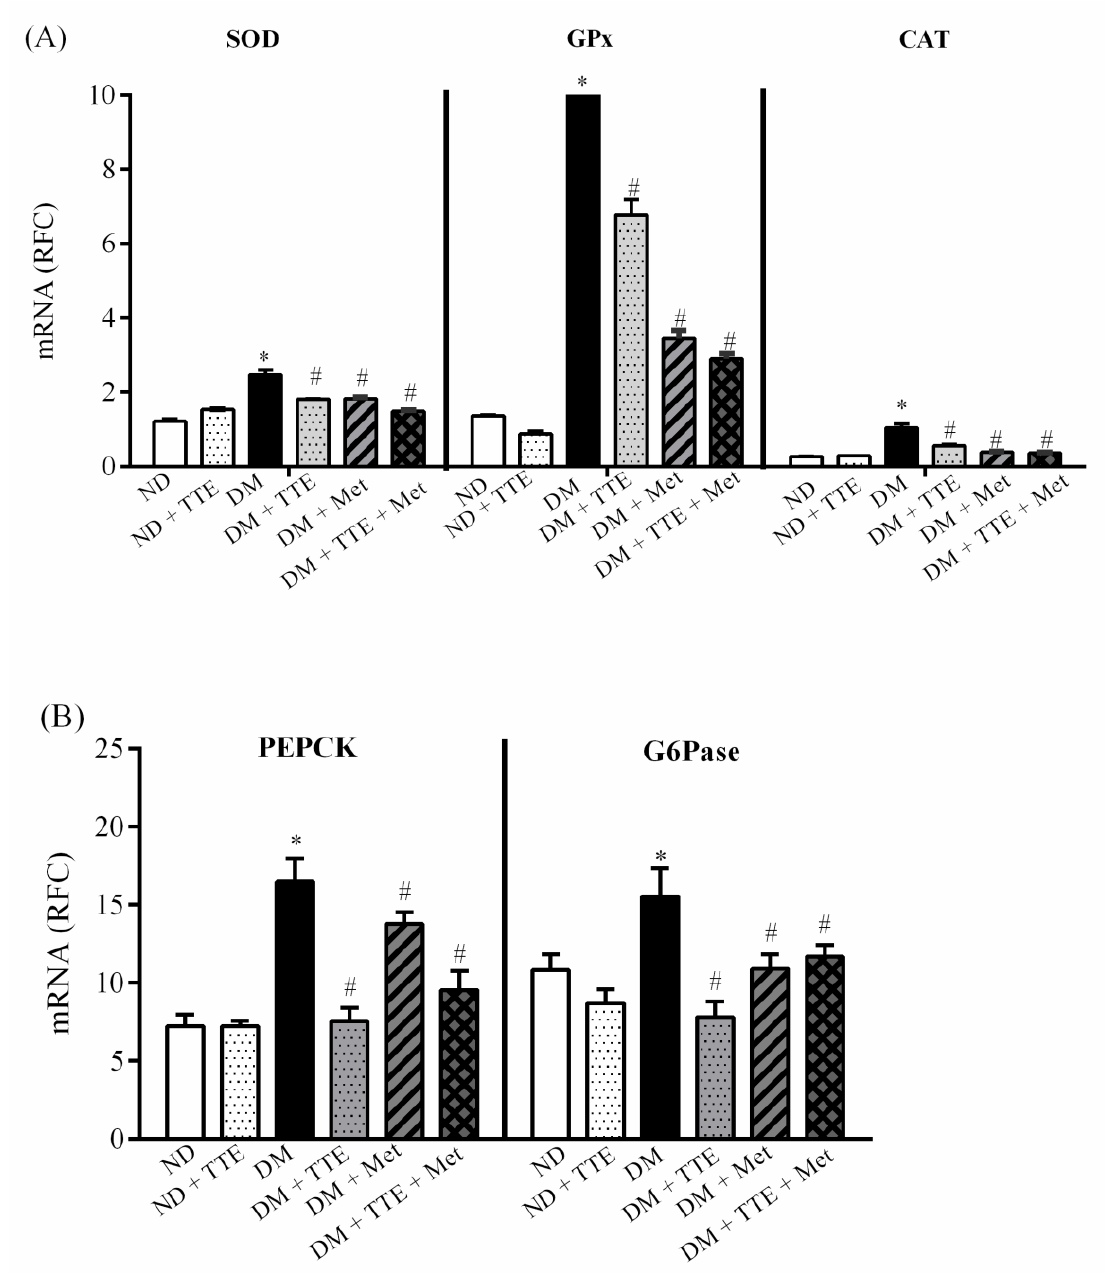
Figure 6. The effect of TTE on genes involved in antioxidant status and hepatic gluconeogenesis in T2DM rats. mRNA expression levels of ( A ) copper-zinc superoxide dismutase (Cu-ZnSOD), glutathione peroxidase (GPx), and catalase (CAT) and ( B ) PEPCK and G6Pase from ND, ND + TTE, DM, DM + TTE, DM + Met and DM + TTE + Met in rat liver. Results are reported as RFC and expressed as mean ± SEM ( n = 5). * p < 0.05 vs. the ND group, # p < 0.05 vs. the DM group.